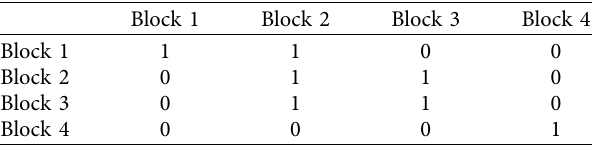
Table 4: Image matrix of the